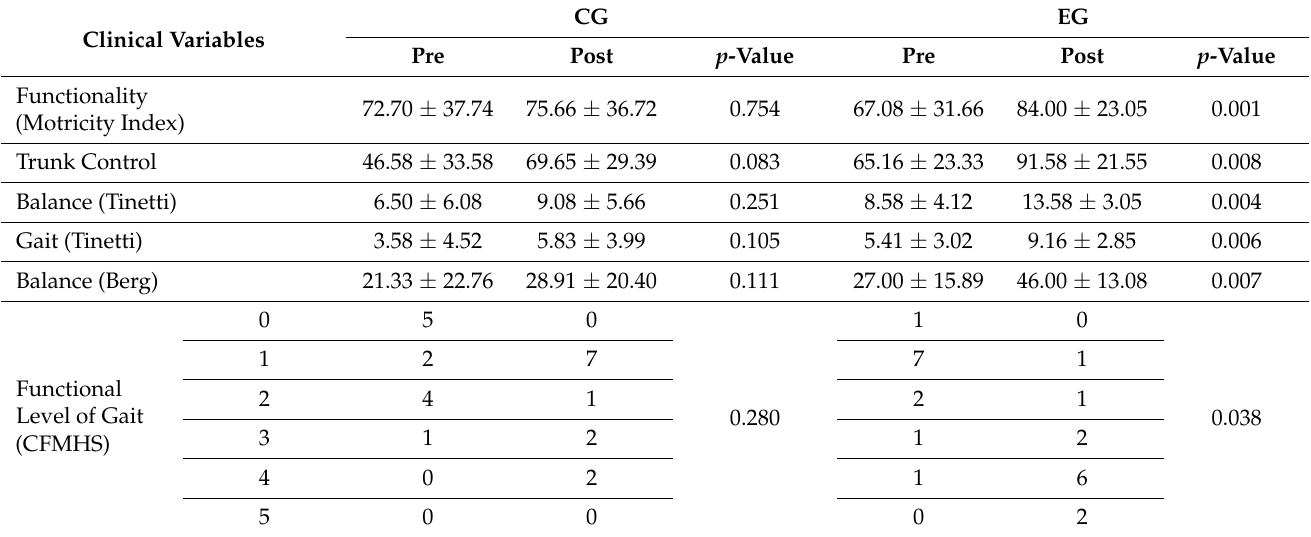
Table 1. Results of Clinical Variables (Mean ±